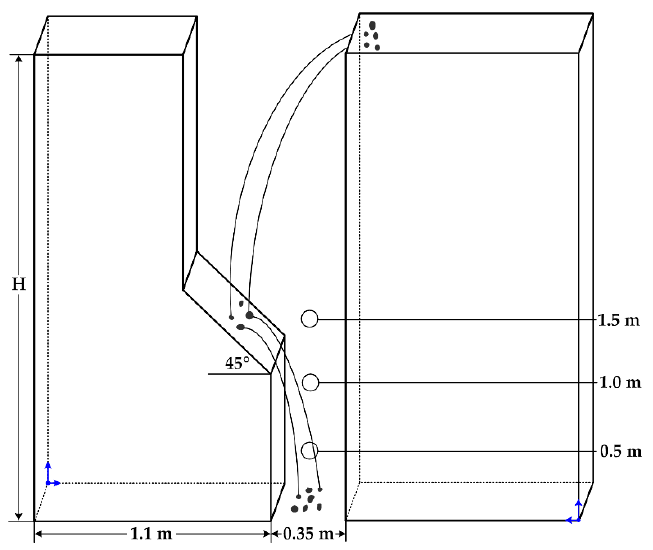
Figure 2. Schematic diagram of the experimental device established in laboratory.